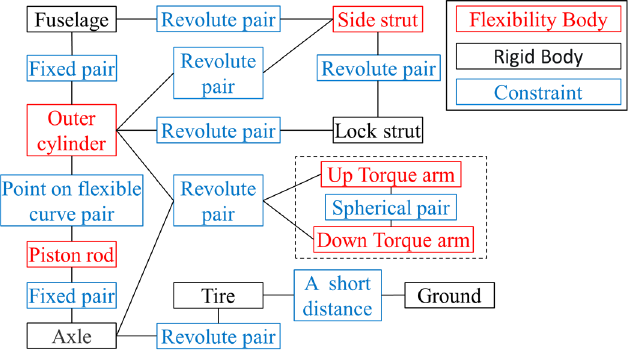
Figure 2. Constraints between the components of the landing gear model.